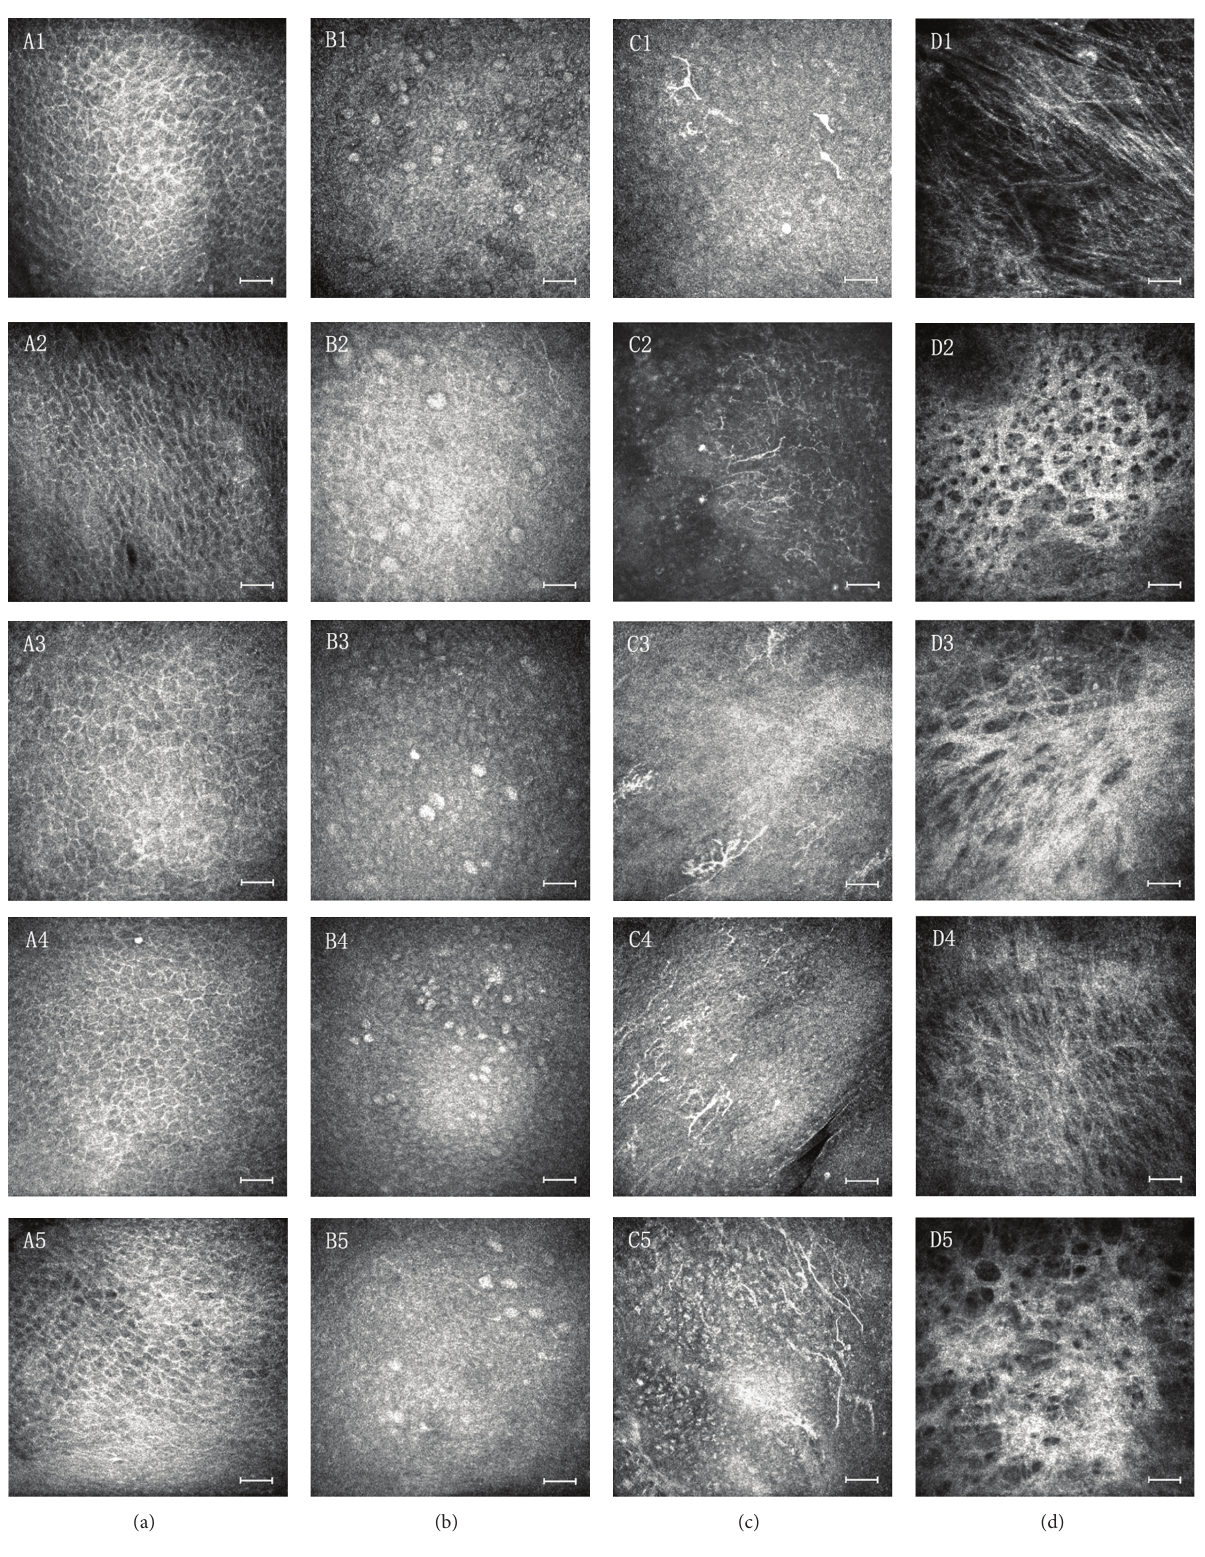
Figure 1: Laser scanning in vivo confocal microscopy of the human conjunctiva in glaucoma patients and control group. (Letter A) Basal epithelial cells of conjunctiva, (Letter B) goblet cells, (Letter C) dendritic cells, and (Letter D) subepithelial fibers. (Number 1) Control group, (Number2)beta-blockersgroup,(Number3)alphaadrenergicagonistsgroup,(Number4)prostaglandingroup,and(Number5)combination therapy group. The scale bar indicates 50 𝜇